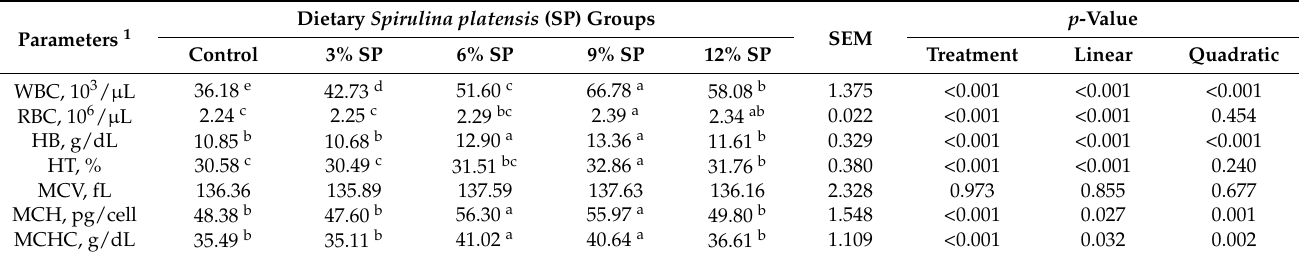
Table 6. Effect of dietary Spirulina platensis on the blood hematology of laying